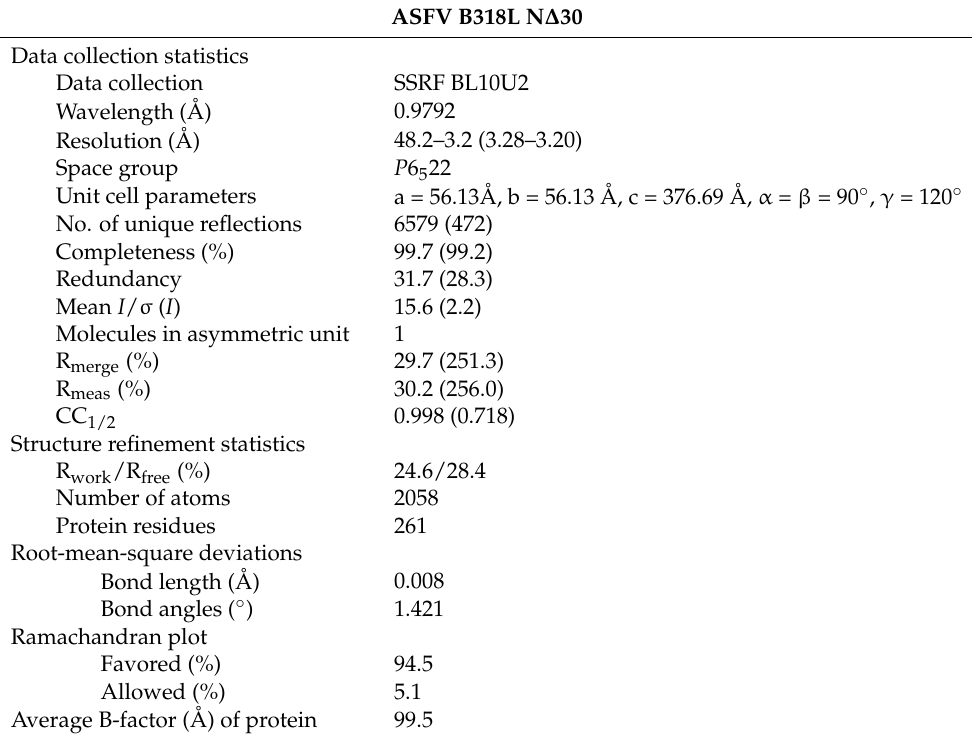
Table 1. Data collection and refinement